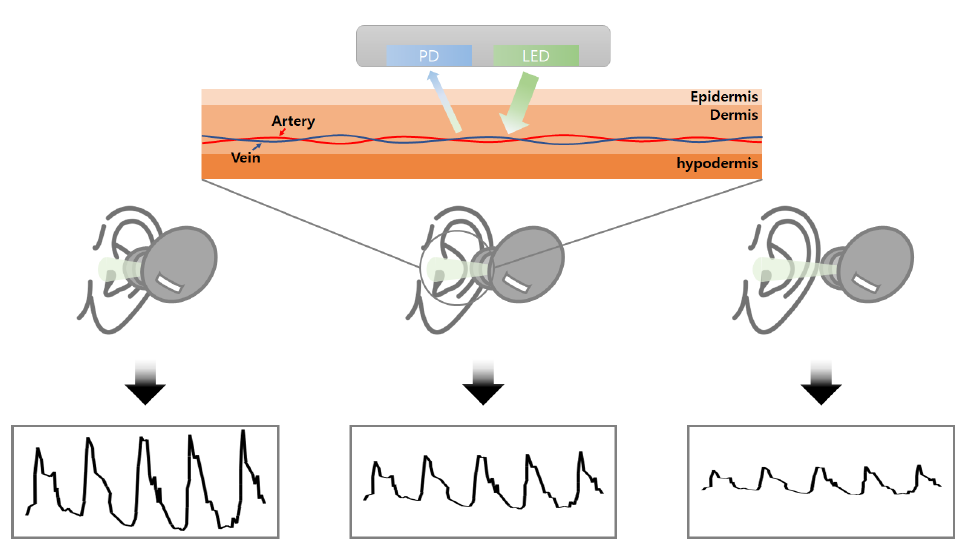
Figure 1. Mechanism of PPG sensor according to the distances between user and the sensor.